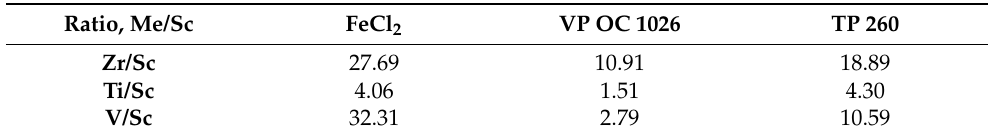
Table 5. Ratios of metal impurities concentration to Sc concentration in the three examined phases: FeCl 2 solution, VP OC 1026 resin and TP 260